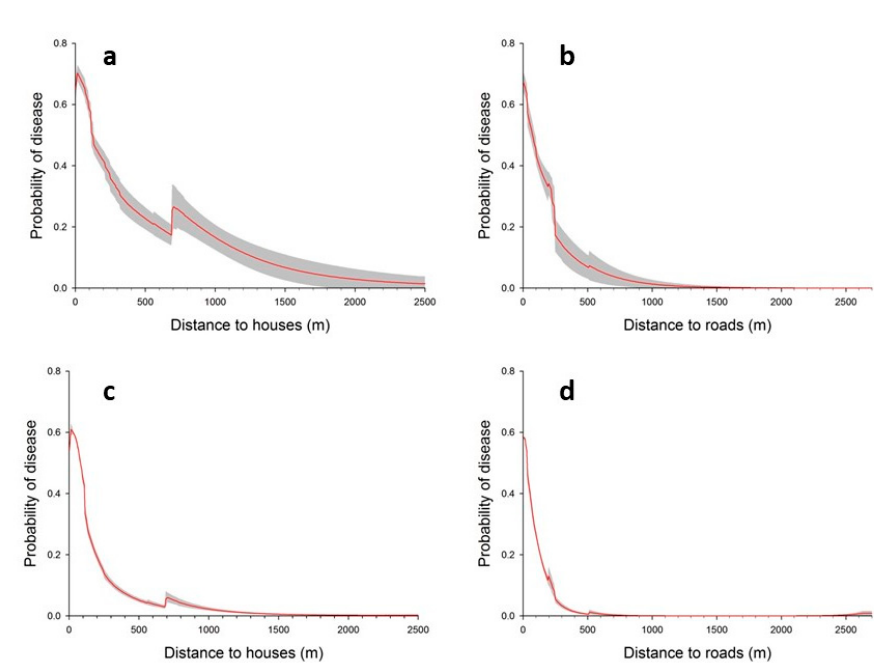
Figure 3. Austrocedrus disease risk according to MaxEnt algoritm in function of distance to houses ( a , c ) and distance to roads ( b , d ). Curves a and b show how the logistic prediction changes as each environmental variable is varied, keeping all other environmental variables at their average sample value; while curves c and d represent a Maxent model created using only the corresponding variable. Mean value ± 1 standard deviation (gray area) is shown in each case.